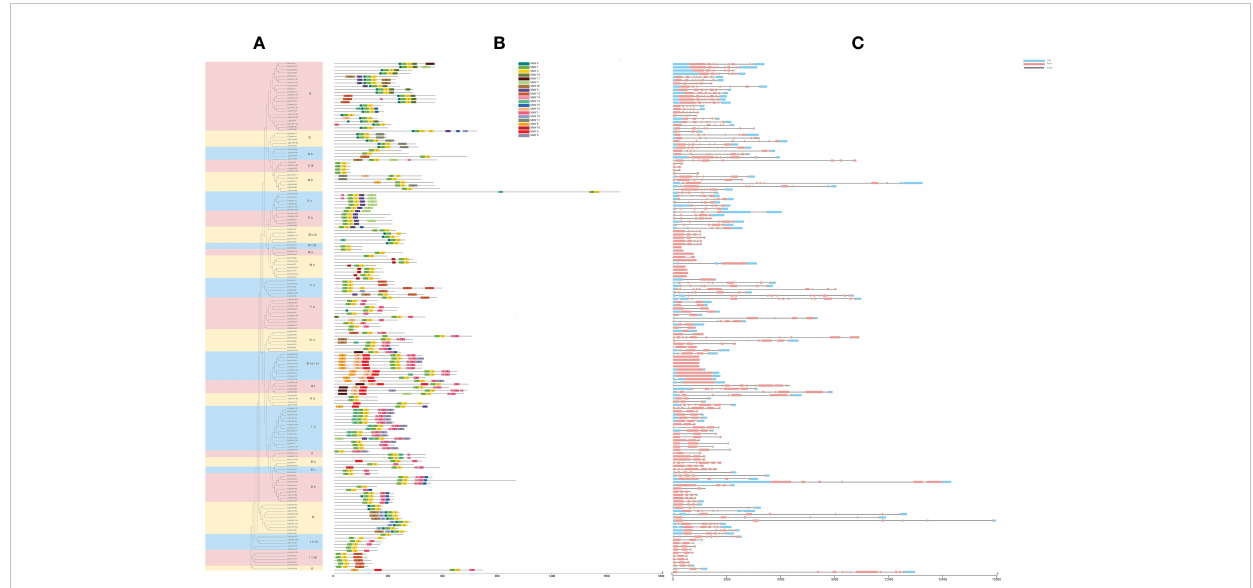
FIGURE 5 Analysis of conserved motifs and gene structure for 159 CpbHLH proteins. (A) Phylogenetic tree. (B) Distribution of conserved motifs. Twenty motifs were represented by twenty kinds of colored blocks. The position of each block represents the location of the motif. (C) organization of gene structure. The length of the gray line represents the length of a sequence relative to that of all the other